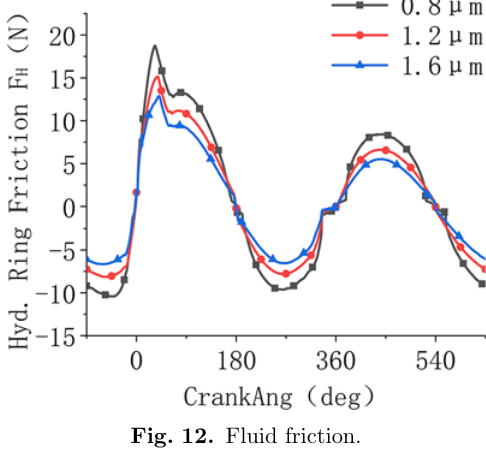
Fig. 12. Fluid friction.